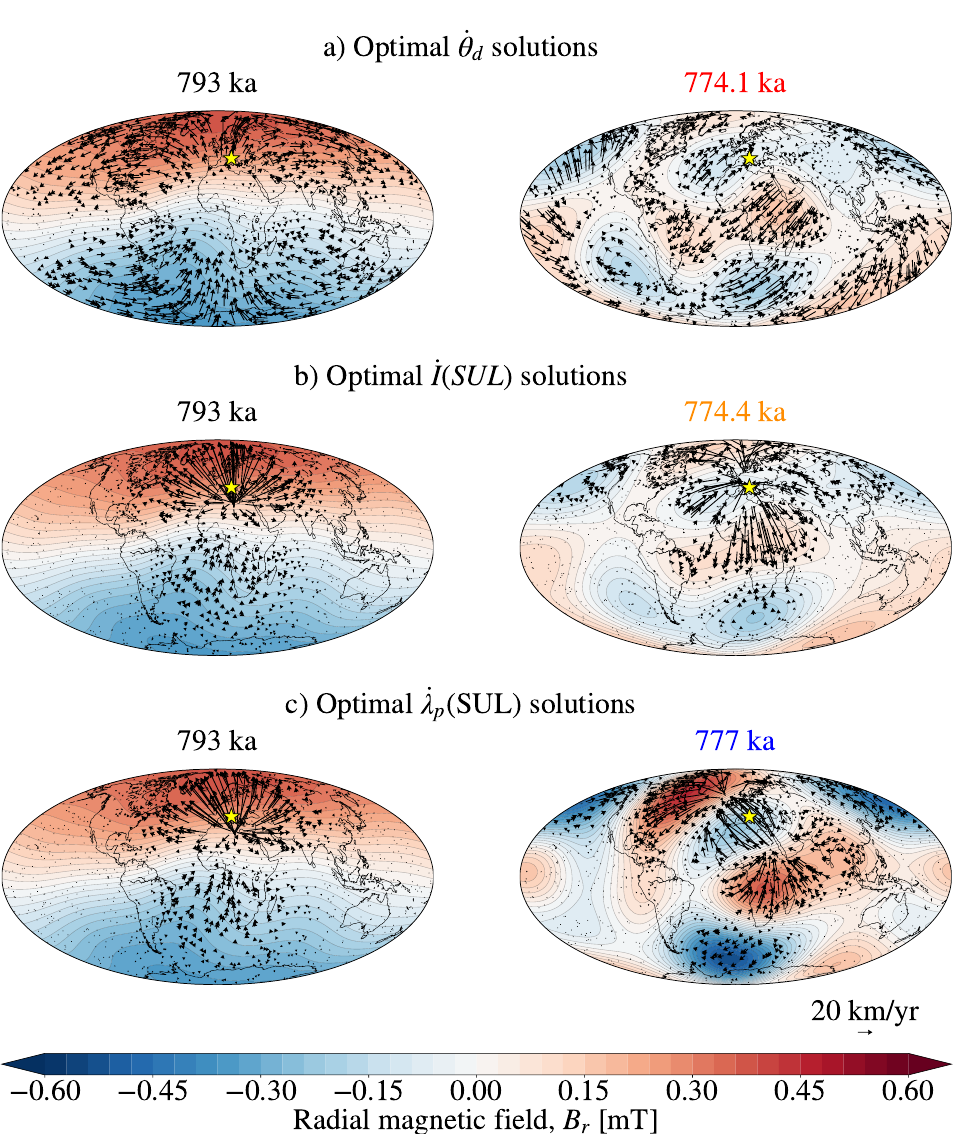
Figure 8. Optimal flows and background magnetic field that maximise the instantaneous ˙ θ d ( a ), ˙ I (SUL) ( b ) and ˙ λ p ( SUL ) ( c ) at the indicated epochs for T 0 = 13 km/y. These flows produce instanta- neous realisations of the optimal solutions shown in Figure 7. The yellow star in the right column indicates the SUL location. The left panels refers to the epoch indicated by a continuous vertical line in Figure 7, for which the background field is dominantly dipolar. The right panels show the solutions calculated at the epochs for which the optimised quantities reach their respective maximal values; the indicated epoch is colour coded in the same way as the arrows in Figure 7 to aid the